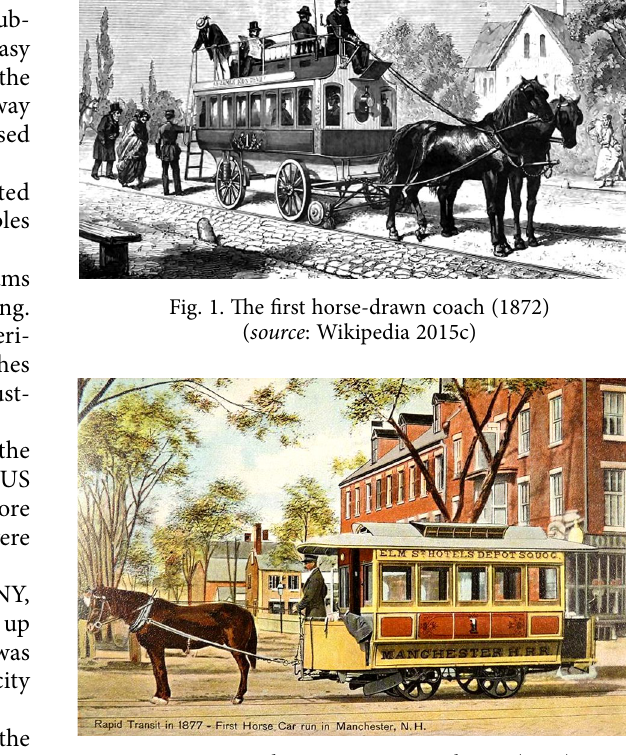
Fig. 2. Horse-drawn tram in Manchester (1877)